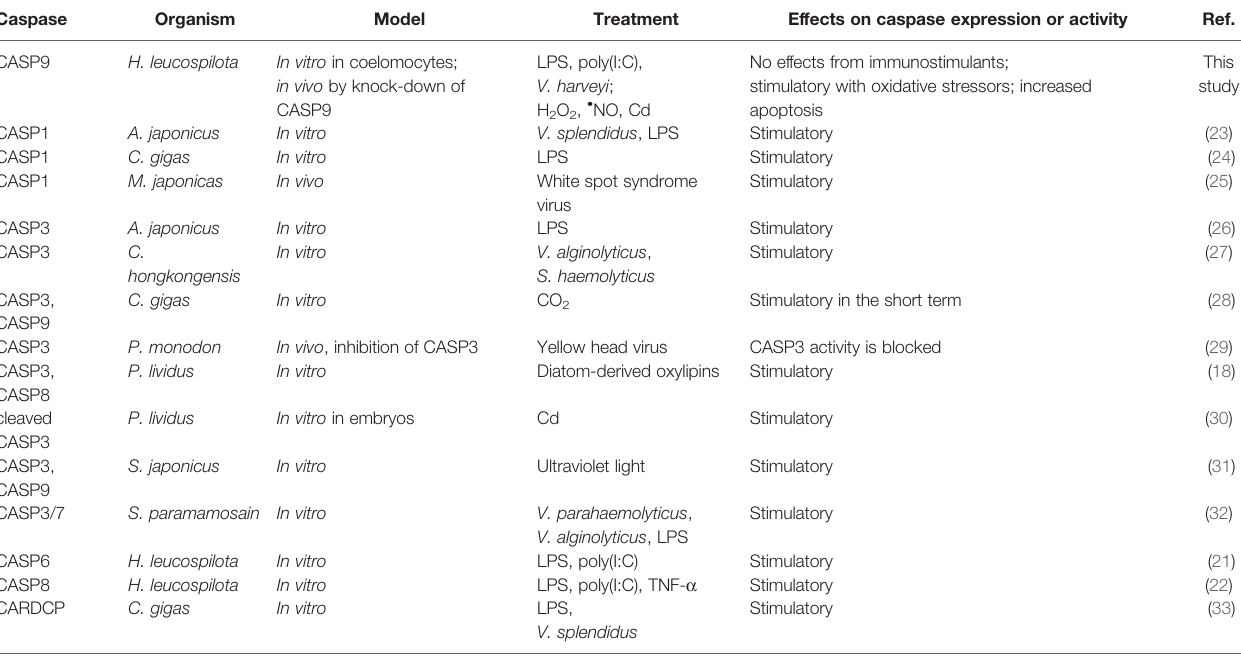
TABLE 1 | Recent works on marine invertebrate caspases in immunological or toxicological